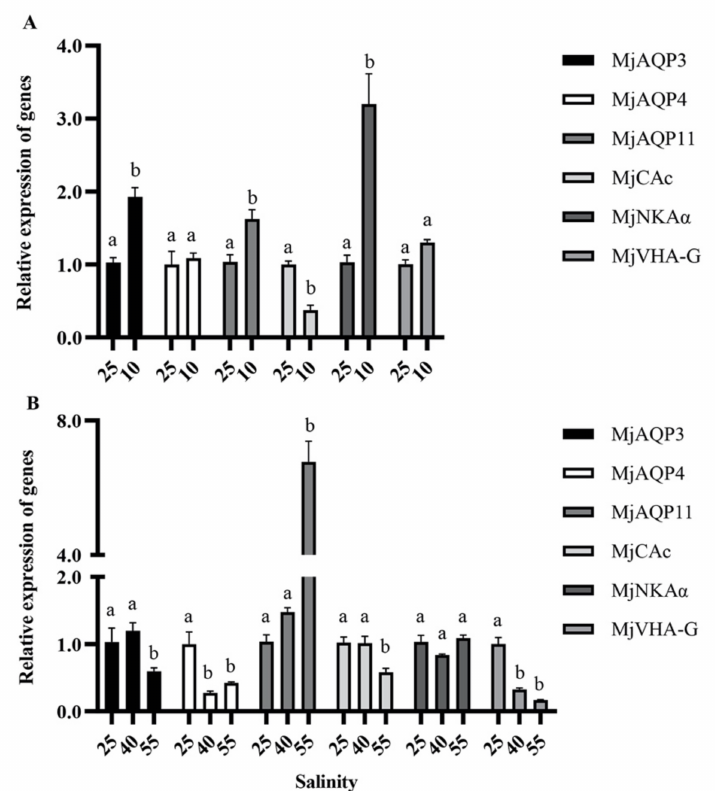
Figure 7. The relative expression levels of genes during the low-salinity ( A ) and high-salinity ( B ) acclimation periods in the gills. The relative expression level of each gene at 25‰ salinity is separately used as calibrator. The data are presented as mean + SD ( n = 3). Lowercase letters indicate significant differences ( p < 0.05) with each